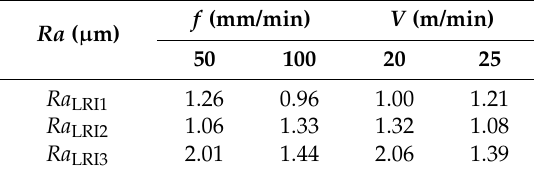
Table 6. Ra ( µ m) mean values in the three measured zones versus the feed rate, f , and the cutting speed, V